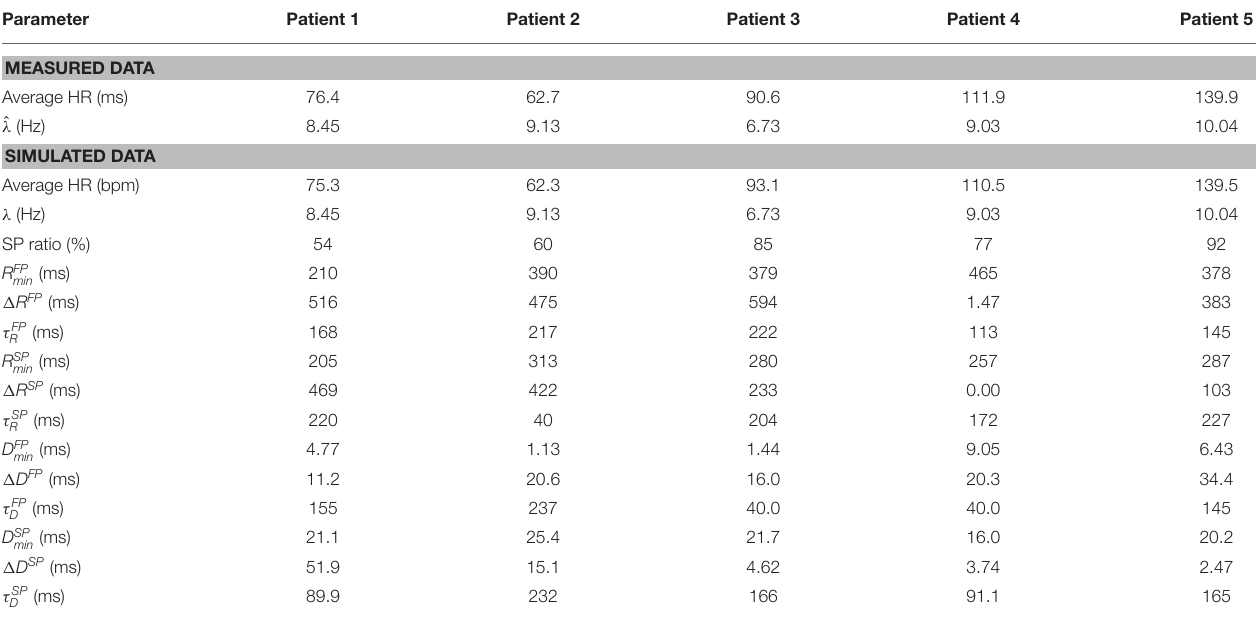
TABLE 1 | Characteristics of the data extracted from ECG and the simulated data, respectively, for all five